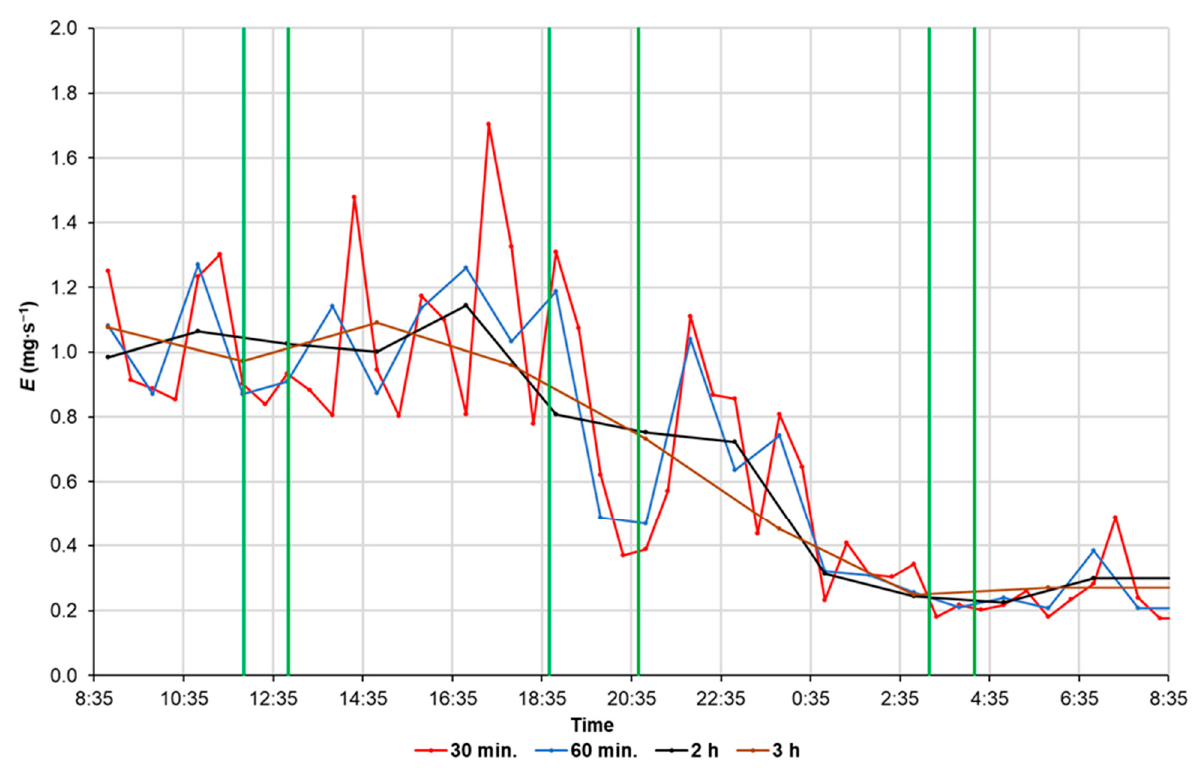
Figure 8. Dependence of the E value on time for different time window widths for model data (the vertical green lines indicate artificially modified intervals).